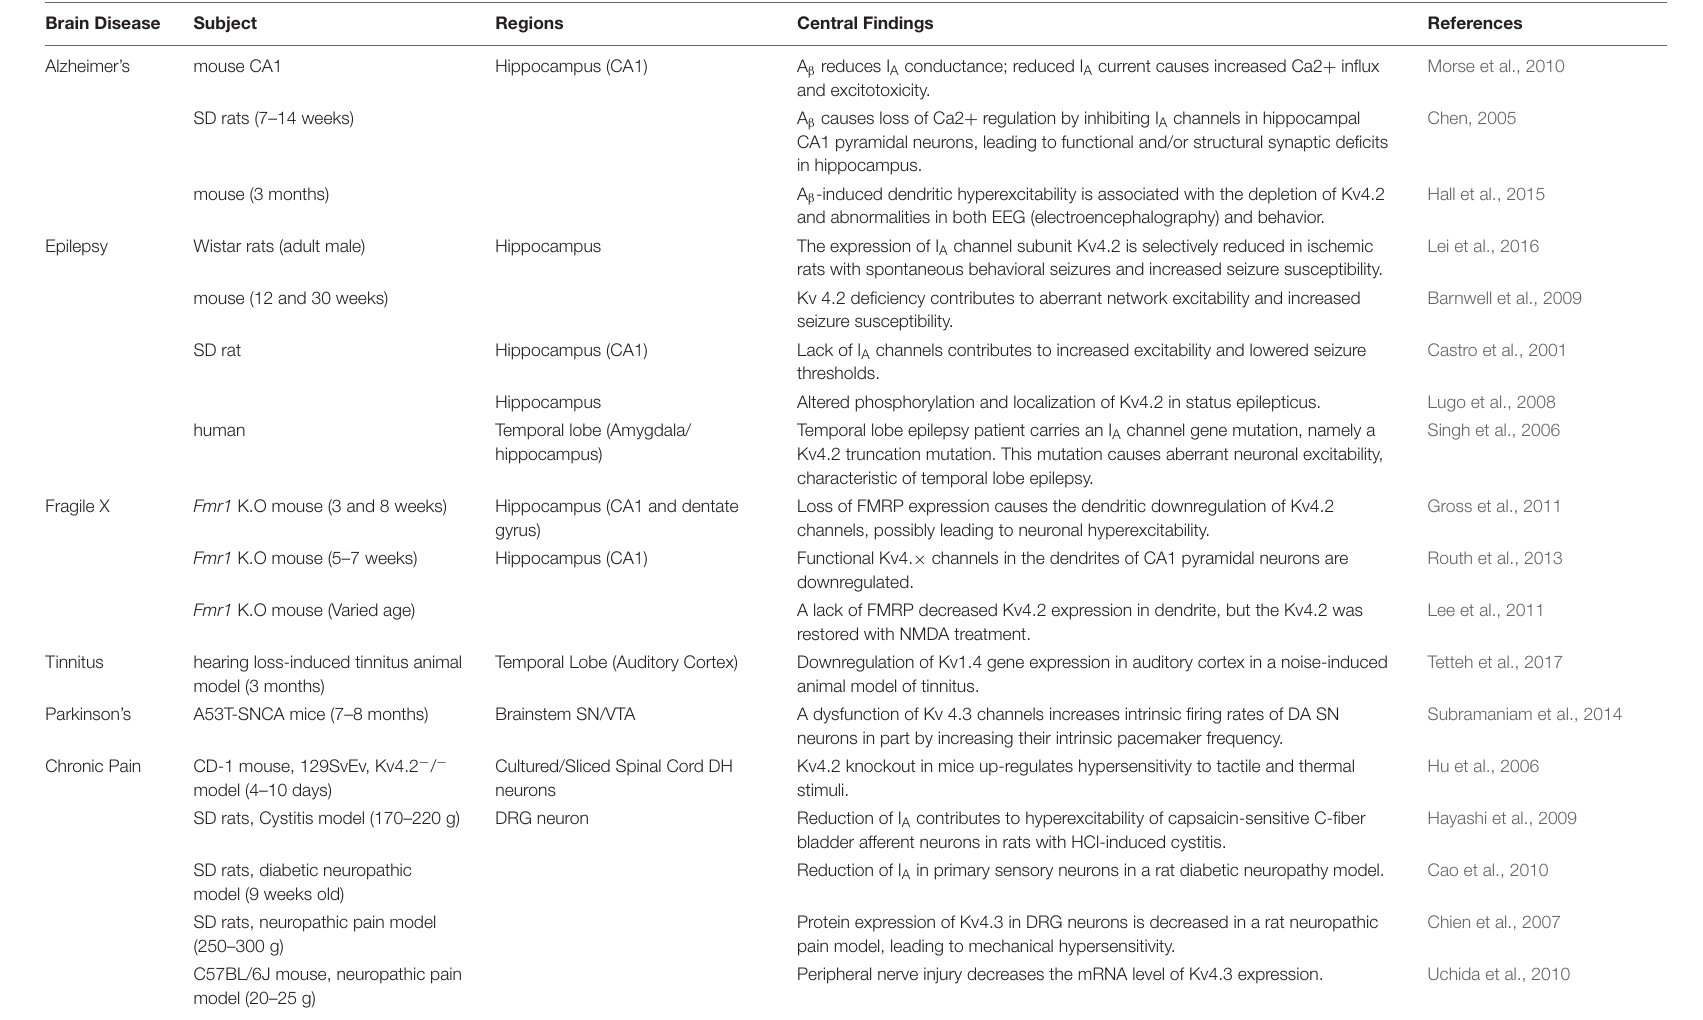
TABLE 2 | The close association of I A channel activity and expression in brain diseases. Brain